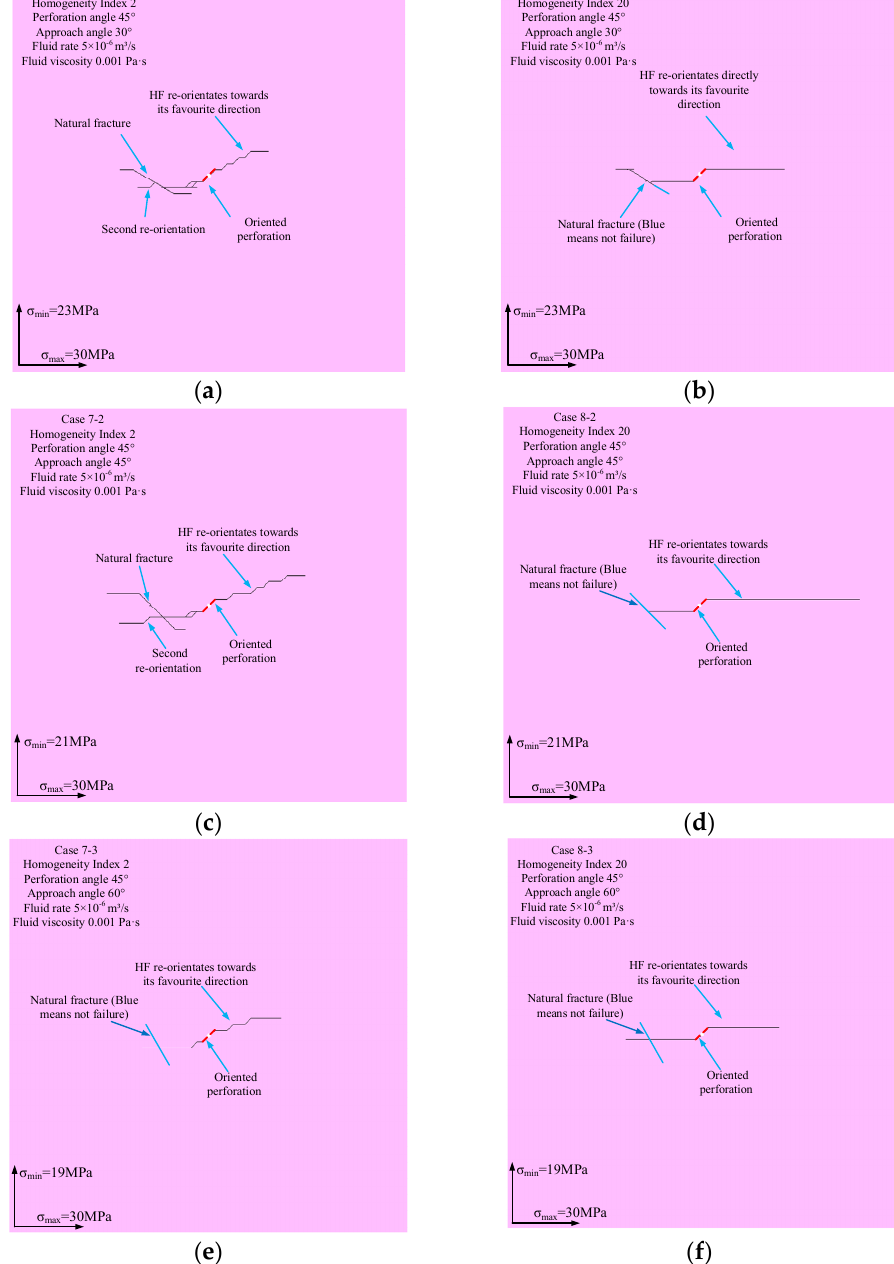
Figure 13. The relationship between HF re-orientation and NFs: ( a ) the approach angle is 30°, the differential stress is 7 MPa and the homogeneity index is 2; ( b ) the approach angle is 30°, the differential stress is 7 MPa and the homogeneity index is 20; ( c ) the approach angle is 45°, the differential stress is 9 MPa and the homogeneity index is 2; ( d ) the approach angle is 45°, the differential stress is 9 MPa and the homogeneity index is 20; ( e ) the approach angle is 60°, the differential stress is 11 MPa and the homogeneity index is 2; ( f ) the approach angle is 60°, the differential stress is 11 MPa and the homogeneity index is 20.